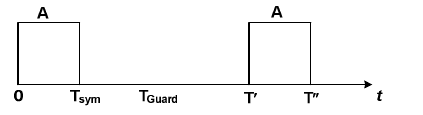
Fig. 1 Pulse-transmitted OOK signaling: T ′′′′ = T sym + T Guard and T ″″″″ = 2 T sym + T Guard . Here T Guard is the guard time between successive